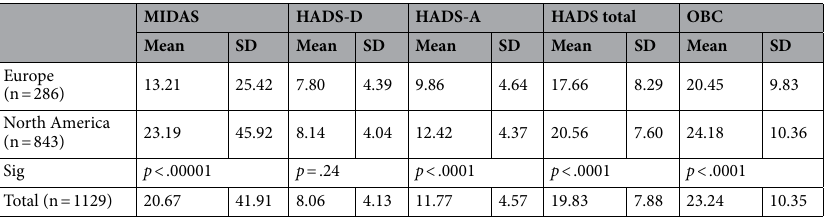
Table 2. Mean scores for the MIDAS, HADS-D, HADS-A, HADS total and OBC in European and North American residents (SD—standard deviation). SD—standard deviation, MIDAS—Migraine Disability Assessment, HADS—Hospital Anxiety and Depression Scale, OBC—Oral Behaviors Checklist, sig.— p -value for the statistical significance of the analyzed differences (see main text for details).